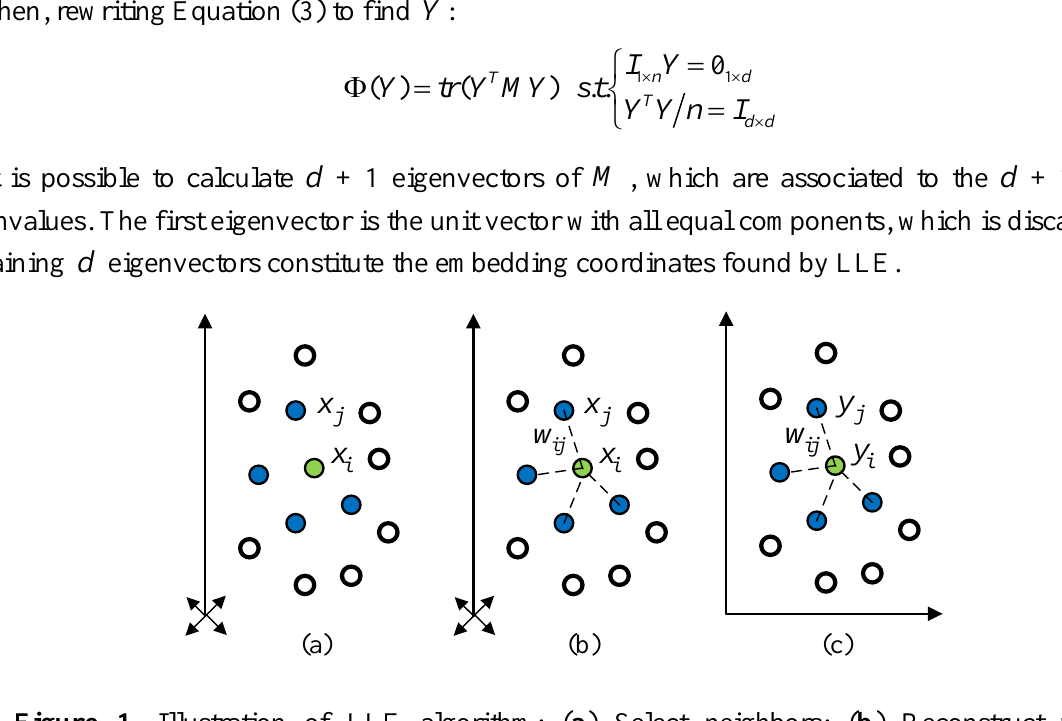
Figure 1. Illustration of LLE algorithm: ( a ) Select neighbors; ( b ) Reconstruct with embedded linear weights; ( c ) Map to